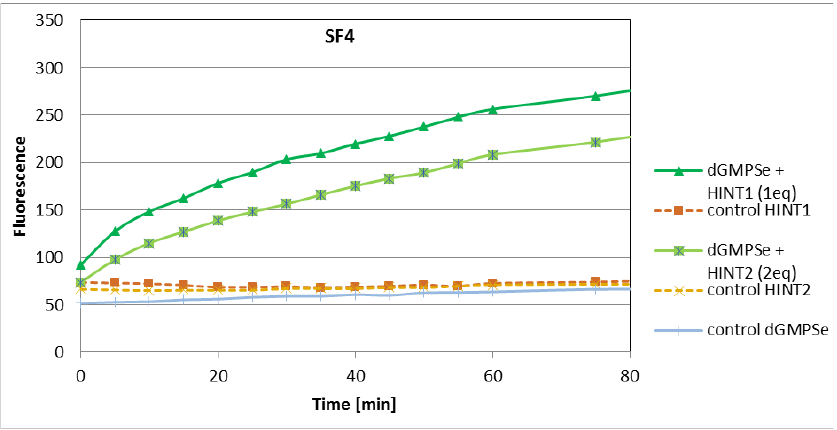
Figure 5. Comparison of the activity of HINT1 and HINT2 against dGMPSe shown in the fluorescence assay using the SF4 probe.